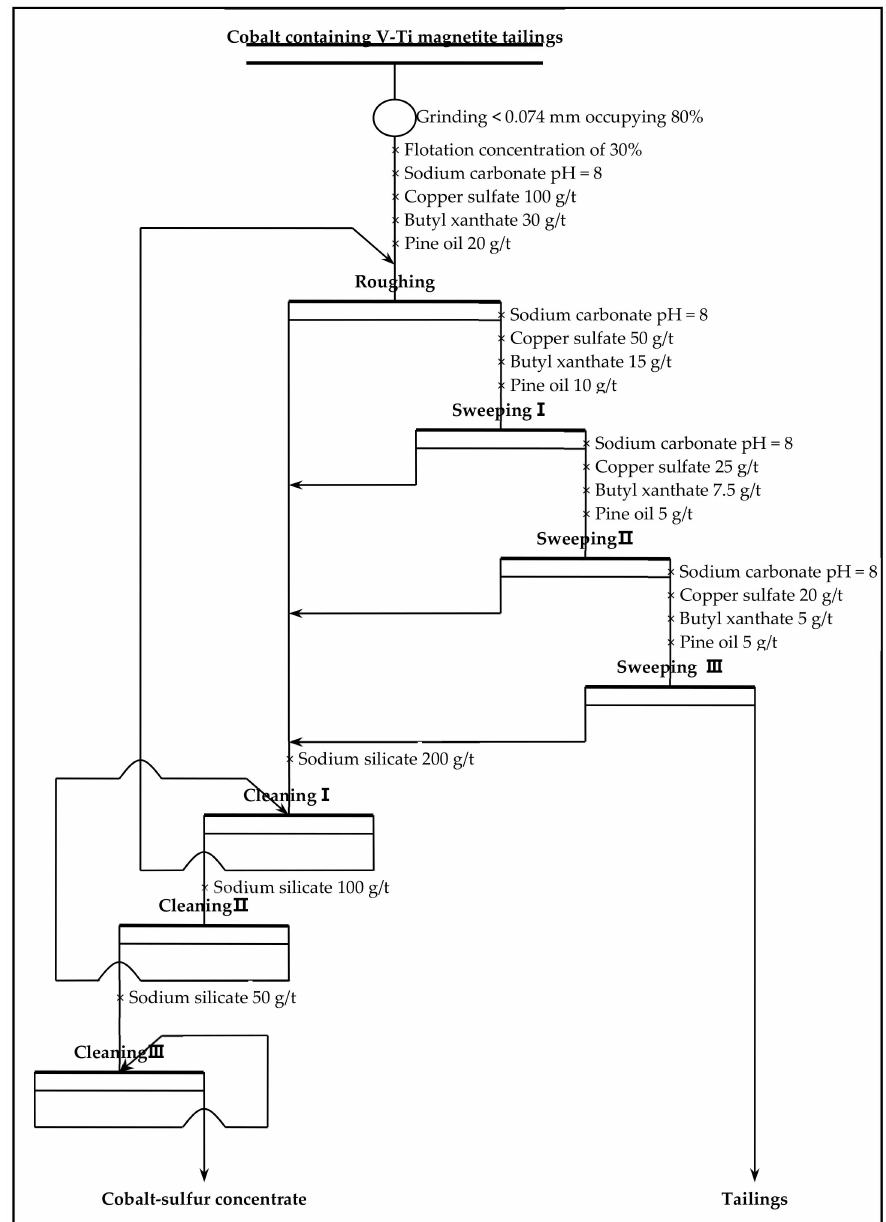
Figure 10. The whole flotation test flowsheet of recovering